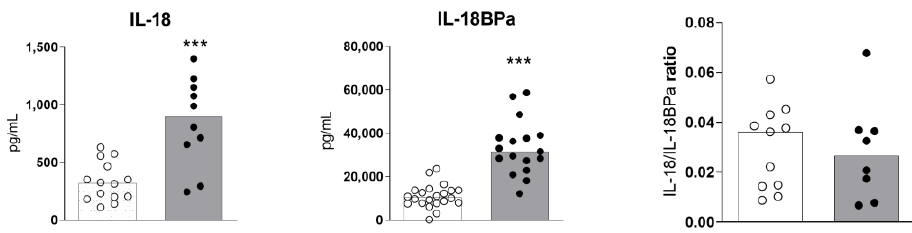
Figure 2. High circulating levels of IL-18- and IL-18-binding protein a (BPa) in SS patients. Serum determinations of IL-18 and IL-18BPa were assessed by ELISA (SS, n = 10–19; HD, n = 13–22). The IL18/IL18BP ratios were also calculated. The values are expressed as medians. *** p ≤ 0.001.